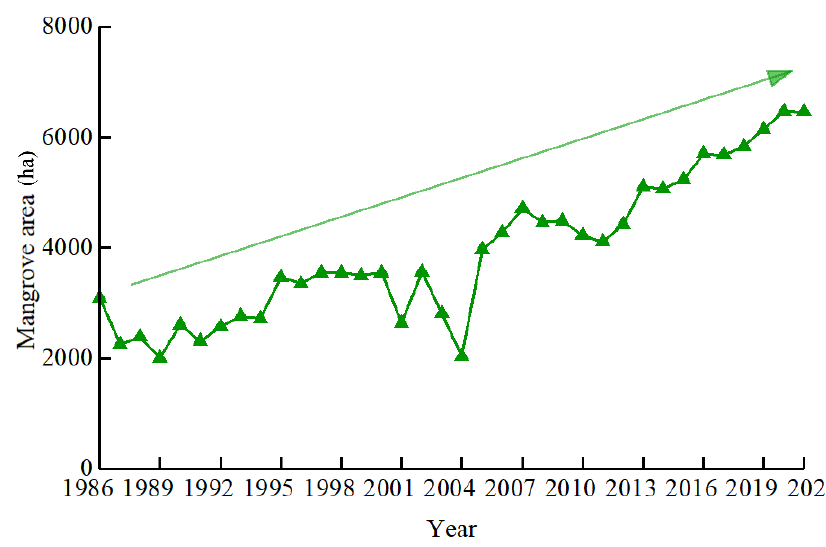
Figure 8. Mangrove area in ZMNR during 1986 – 2021.